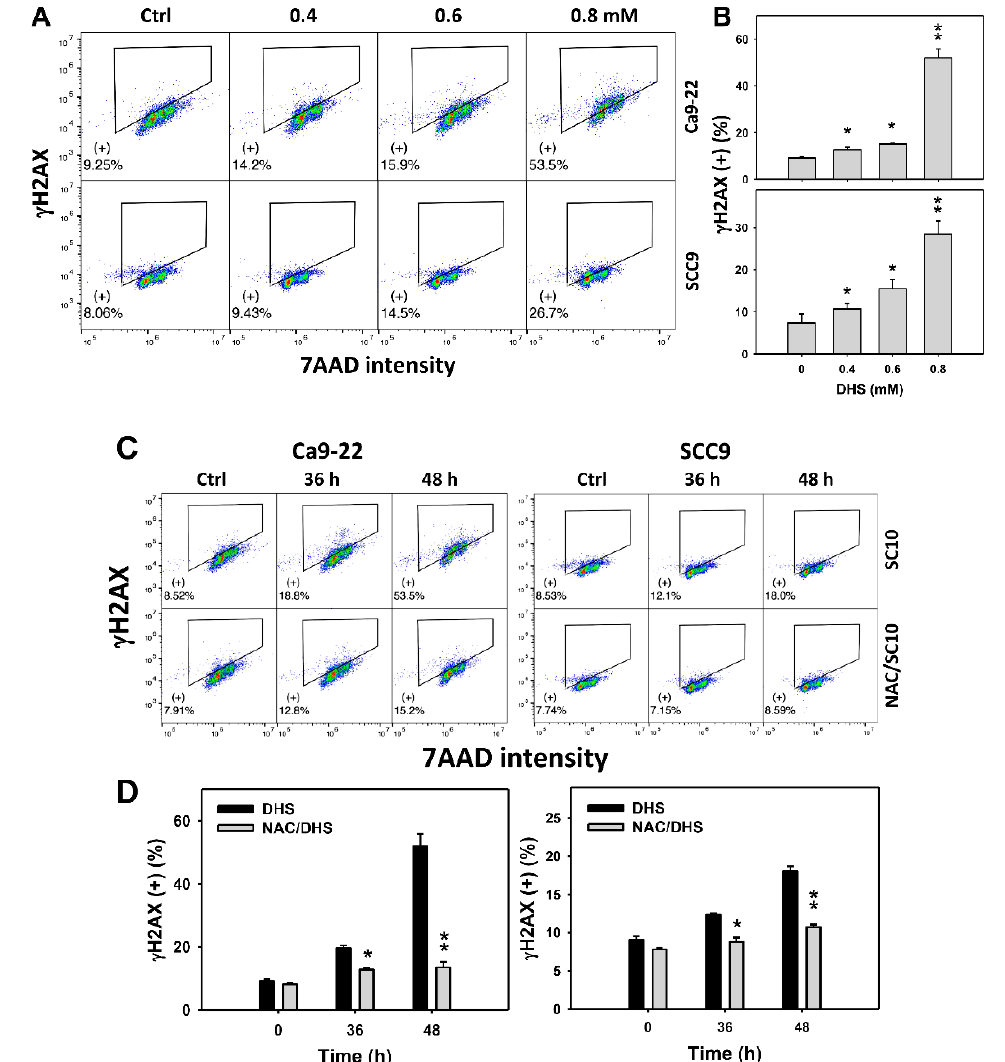
Figure 8. DHS effects on γ H2AX contents of oral cancer cells. ( A , B ) Representative γ H2AX patterns of DHS-treated oral cancer cells. Cells (Ca9-22 and SCC-9) were treated with 0.4, 0.6, and 0.8 mM DHS or vehicle (containing 0.08% DMSO) for 48 h. (+) indicates the high γ H2AX populations. ( C , D ) Alleviation of the γ H2AX changes of DHS-treated oral cancer cells by NAC. Cells were pretreated with NAC (10 mM, 1 h) or not, and then they were treated with 0.6 mM DHS or vehicle for 0, 36 and 48 h. Data = means ± SDs ( n = 3 independent experiments). * and ** indicate significant differences between ( A , B ) DHS and control and ( C , D ) DHS and NAC/DHS ( p < 0.05 and 0.01, respectively). A positive control for γ H2AX phosphorylation of oral cancer cells is provided in Supplementary Figure